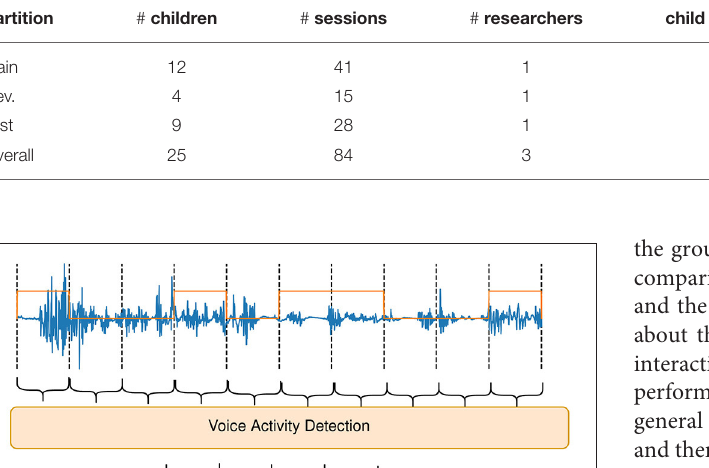
TABLE 1 | Overview of the three partitions of the data set: train, development (dev.), and test. Partition